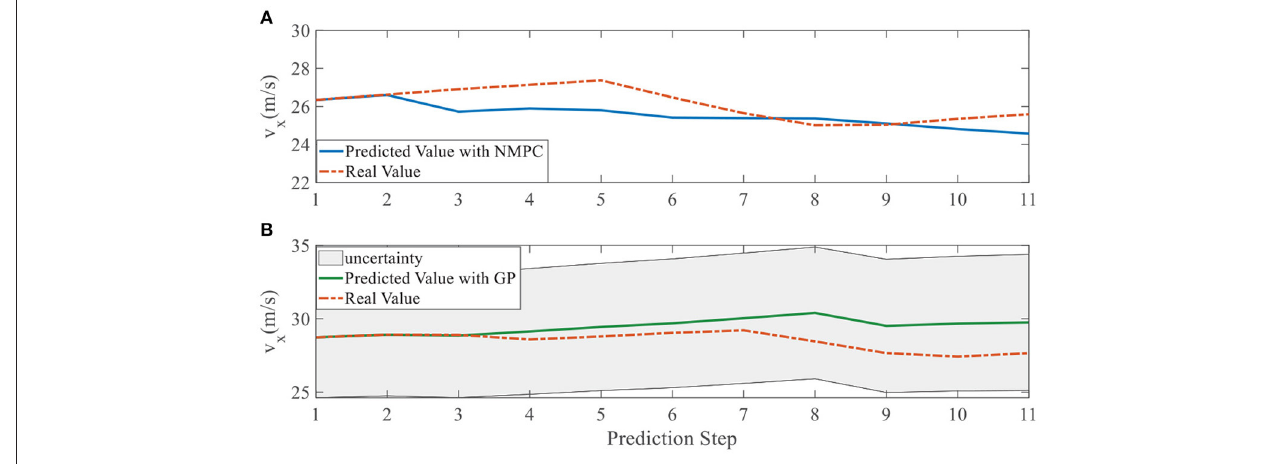
FIGURE 16 | Velocity v x evolution in right overtaking. (A) NMPC; (B) GPMPC.